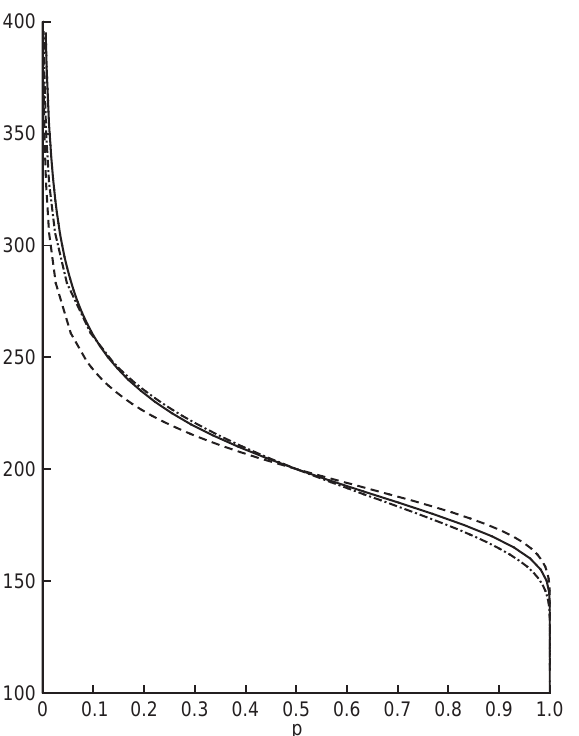
Fig. 1. The ion composition profile p (cid:133) z (cid:134) (cid:136) 1 (cid:255) O (cid:135) calculated by Eq. n e (1), using the neutral atmosphere from the MSIS 90 model ( continuous lines ) and z 50 =200, t 050 =1.5, and our modelling for z 50 =200, t 050 =1.5 ( dotted lines ) and z 50 =200, t 050 =0.8 ( dash-dotted lines ) Fig. 2. The histogram of the whole set of analysed data in